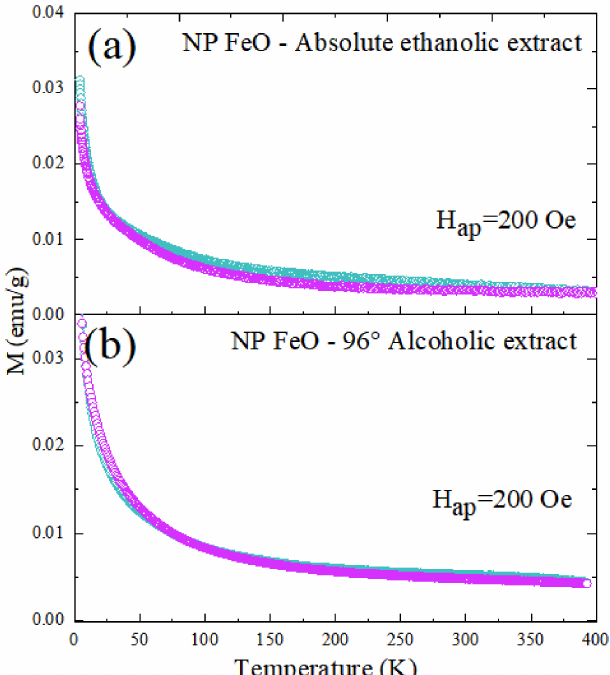
Figure 9. Graph of magnetization as a function of temperature for low fields, with the ZFC and WFC protocols. ( a ) NP FeO Absolute ethanolic extract, ( b ) NP FeO 96% Alcoholic